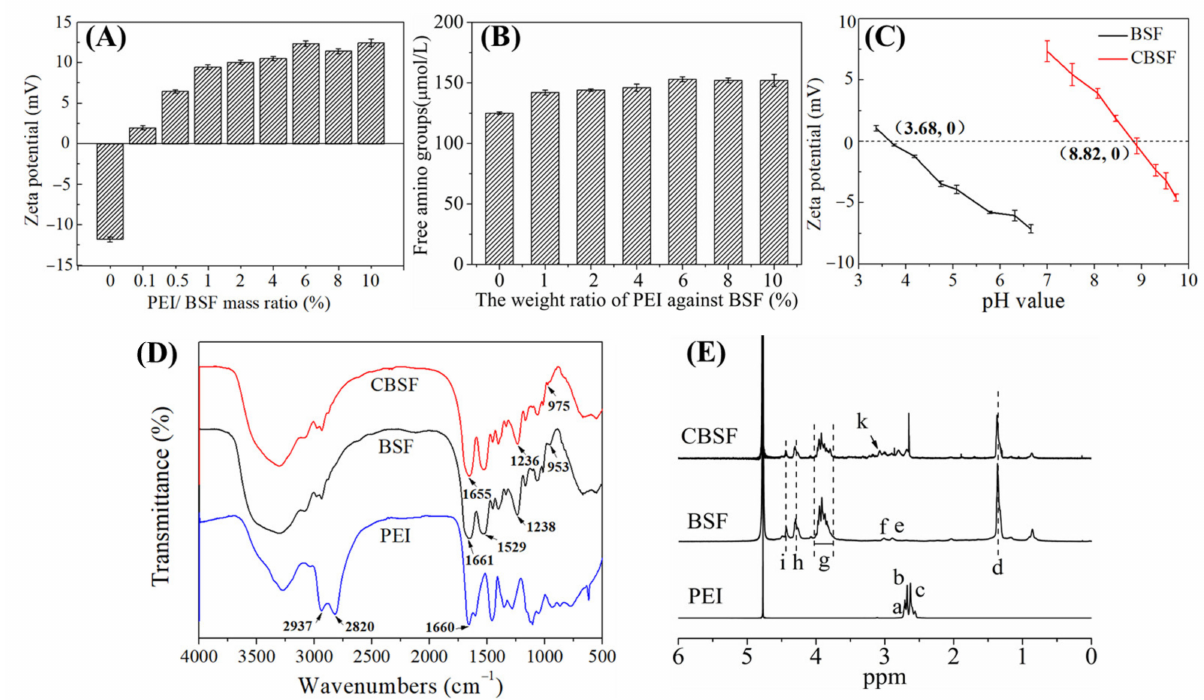
Figure 2. The characteristics of CBSF. ( A ) Zeta potentials of CBSF at different weight ratios of PEI with respect to BSF. ( B ) TNBS assay for the determination of free amino groups in PEI-modified BSF. ( C ) Isoelectric point values of BSF and CBSF (modified with 6.0 wt% PEI against BSF). ( D ) FTIR spectra of PEI, BSF, and CBSF. ( E ) 1 H-NMR spectra of PEI, BSF, and CBSF. a: ~2.71 ppm; b: ~2.68 ppm; c: ~2.62 ppm; d: ~1.24 ppm; e: ~2.78 ppm; f: ~2.91 ppm; g: 3.63~3.91 ppm; h: ~4.18 ppm; i: ~4.32 ppm; k: ~3.12 ppm. Each value represents the mean ± SD of three separate experiments (n = 3 per